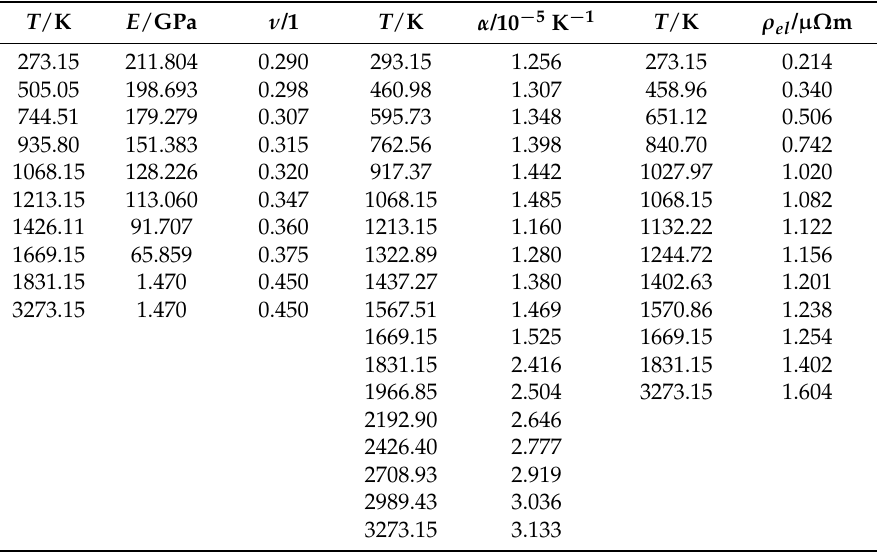
Table 3. Physical properties of 22MnB5.